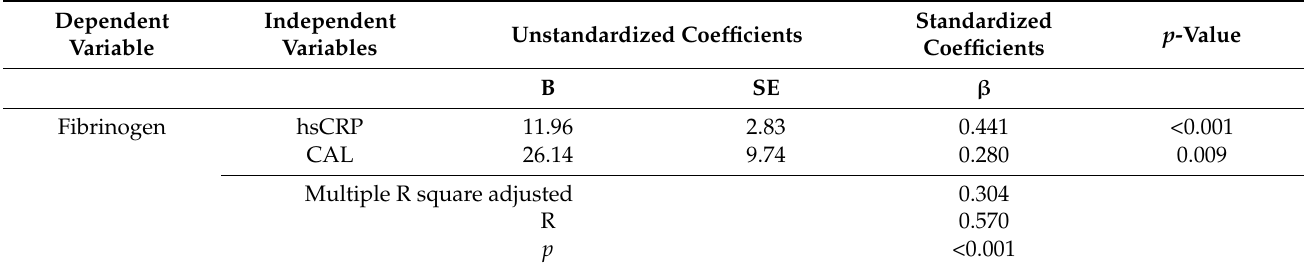
Table 3. Stepwise multivariable regression model with fibrinogen as a dependent